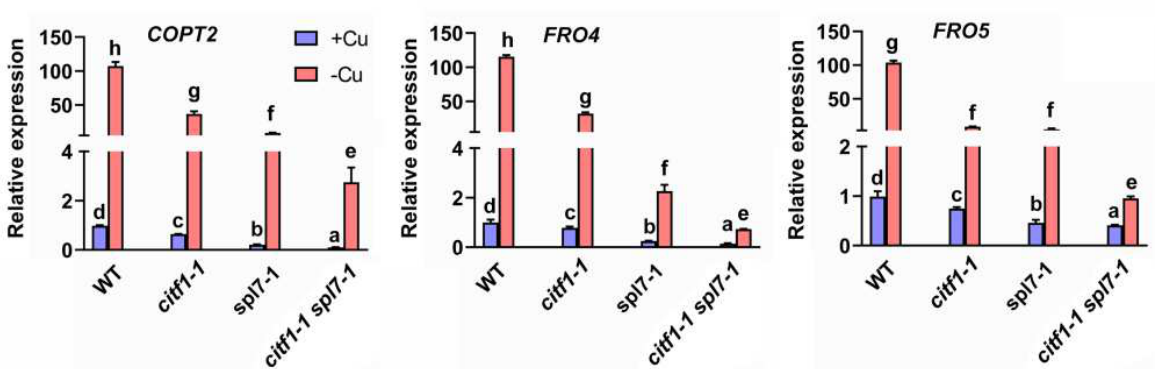
Figure 4. Expression of Cu uptake genes in citf1-1 spl7-1 . Seedlings were grown on +Cu or − Cu medium for 7 days. Roots were used for RNA extraction. Data represent arithmetic means ± SD ( n = 3). Different letters above each bar indicate statistically significant differences (ANOVA, p < 0.01).